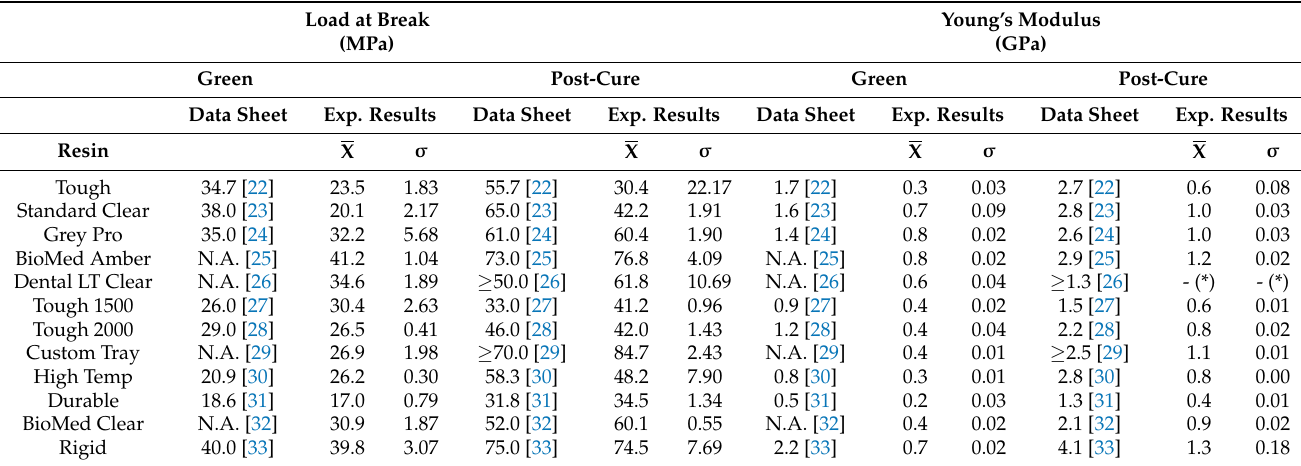
Table 2. Load at break and Young’s modulus values as obtained for each resin. Comparison between green and post-cure conditions. Mean X and standard deviation values σ